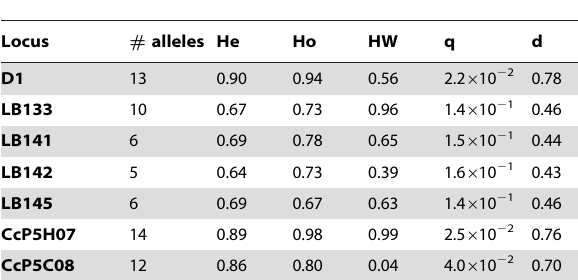
Table 1. For 51 nesting females, the number of alleles per locus, the expected (He) and observed heterozygosities (Ho), Hardy-Weinberg p-value (HW), the probability of two females having the same genotype at a locus (q) and the